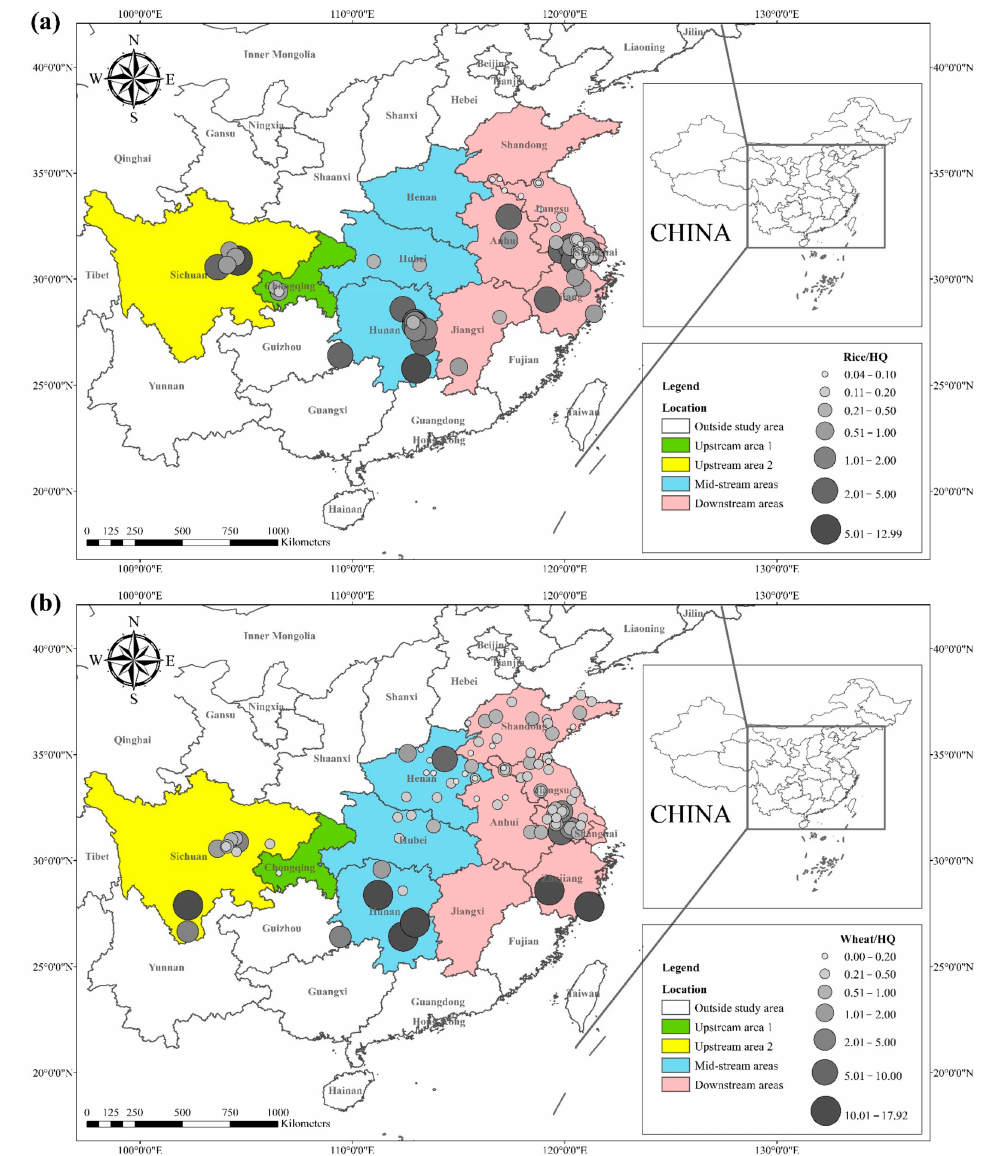
Figure 2. HQ of Cd in ( a ) rice and ( b ) wheat, based on data collected from previous studies. The HQ for the dietary consumption of rice and wheat for the corresponding popu- lations (children (2–6 yrs.), adolescents (7–17 yrs.), and adults ( ≥ 18 yrs.)) are presented in Figures 3 and 4. The areas with a high HQ dietary intake of Cd in rice for children, adolescents, and adults were mainly located in central Sichuan, central and eastern Hunan, northern Anhui, and southern Jiangsu. The HQ value for rice and wheat in Hunan province was 1.8 and 2.6 times higher than the national average dietary Cd intake of 15.3 µ g kg − 1